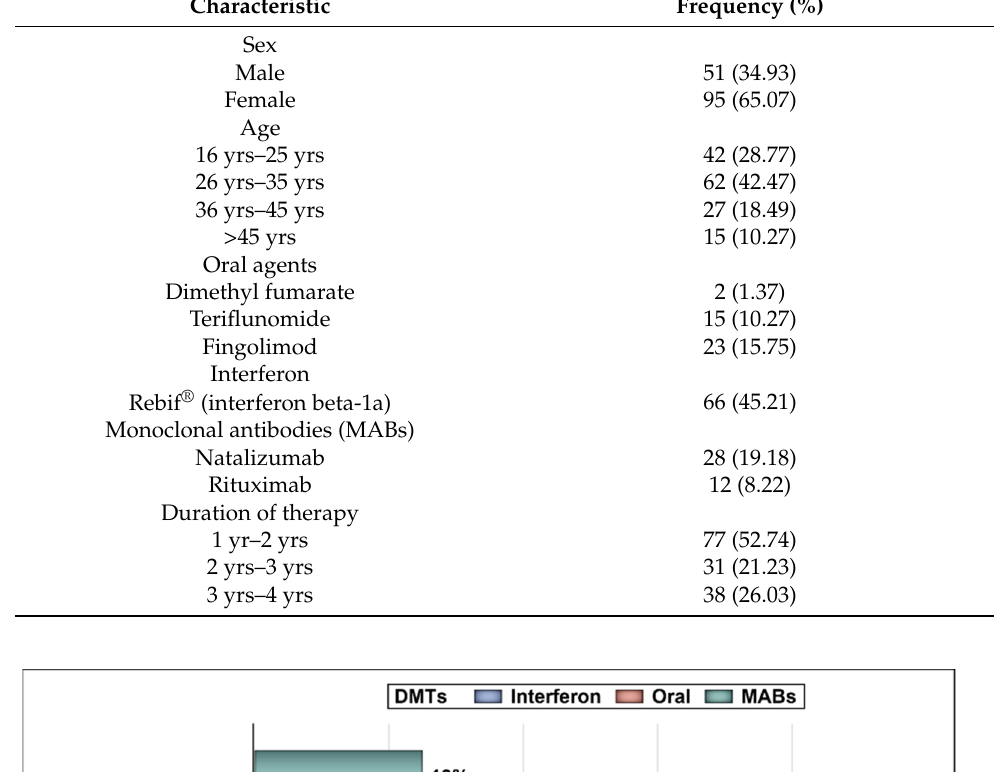
Table 1. Patient baseline characteristics ( n = 146).